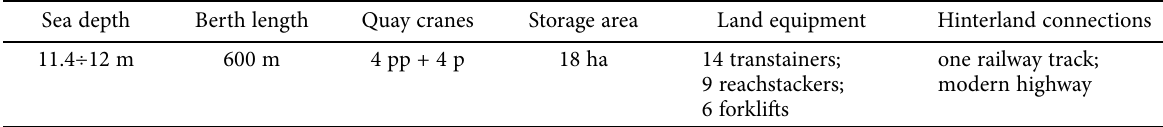
Table 6. The values of the input data for the port of